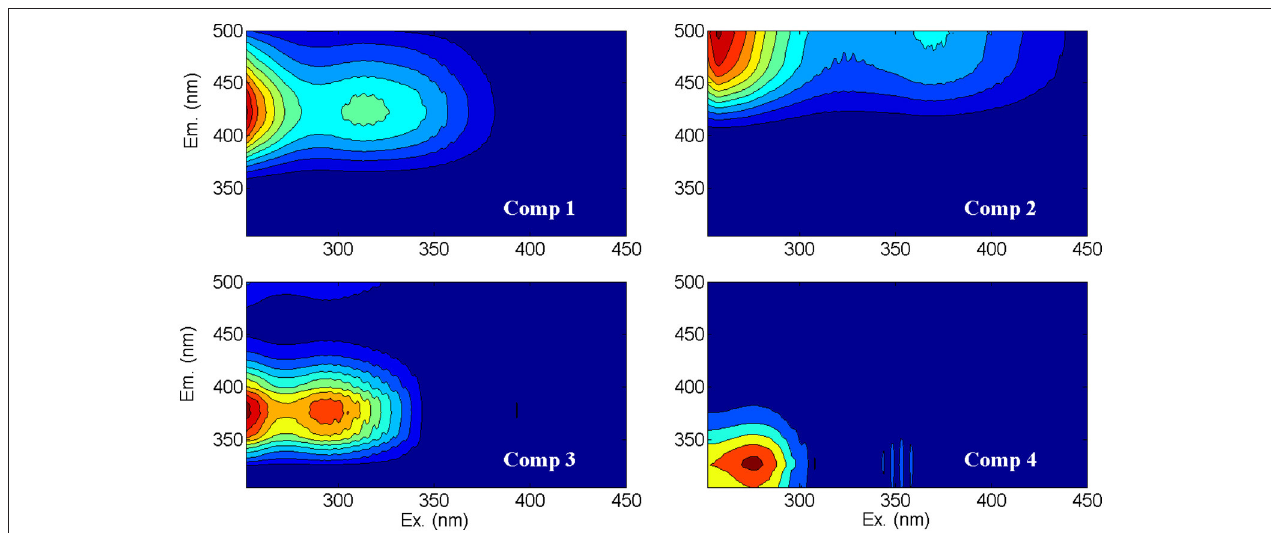
FIGURE 2 | Contour plots of the fluorescent spectra of the four CDOM components (Comp 1 through Comp 4) identified by PARAFAC analysis of Lake Erie EEMs. The model explained 99.8% of the variation within the dataset, with variation explained by each component decreasing in order from component one to component four. Component descriptions and likely sources are in Table 2 .